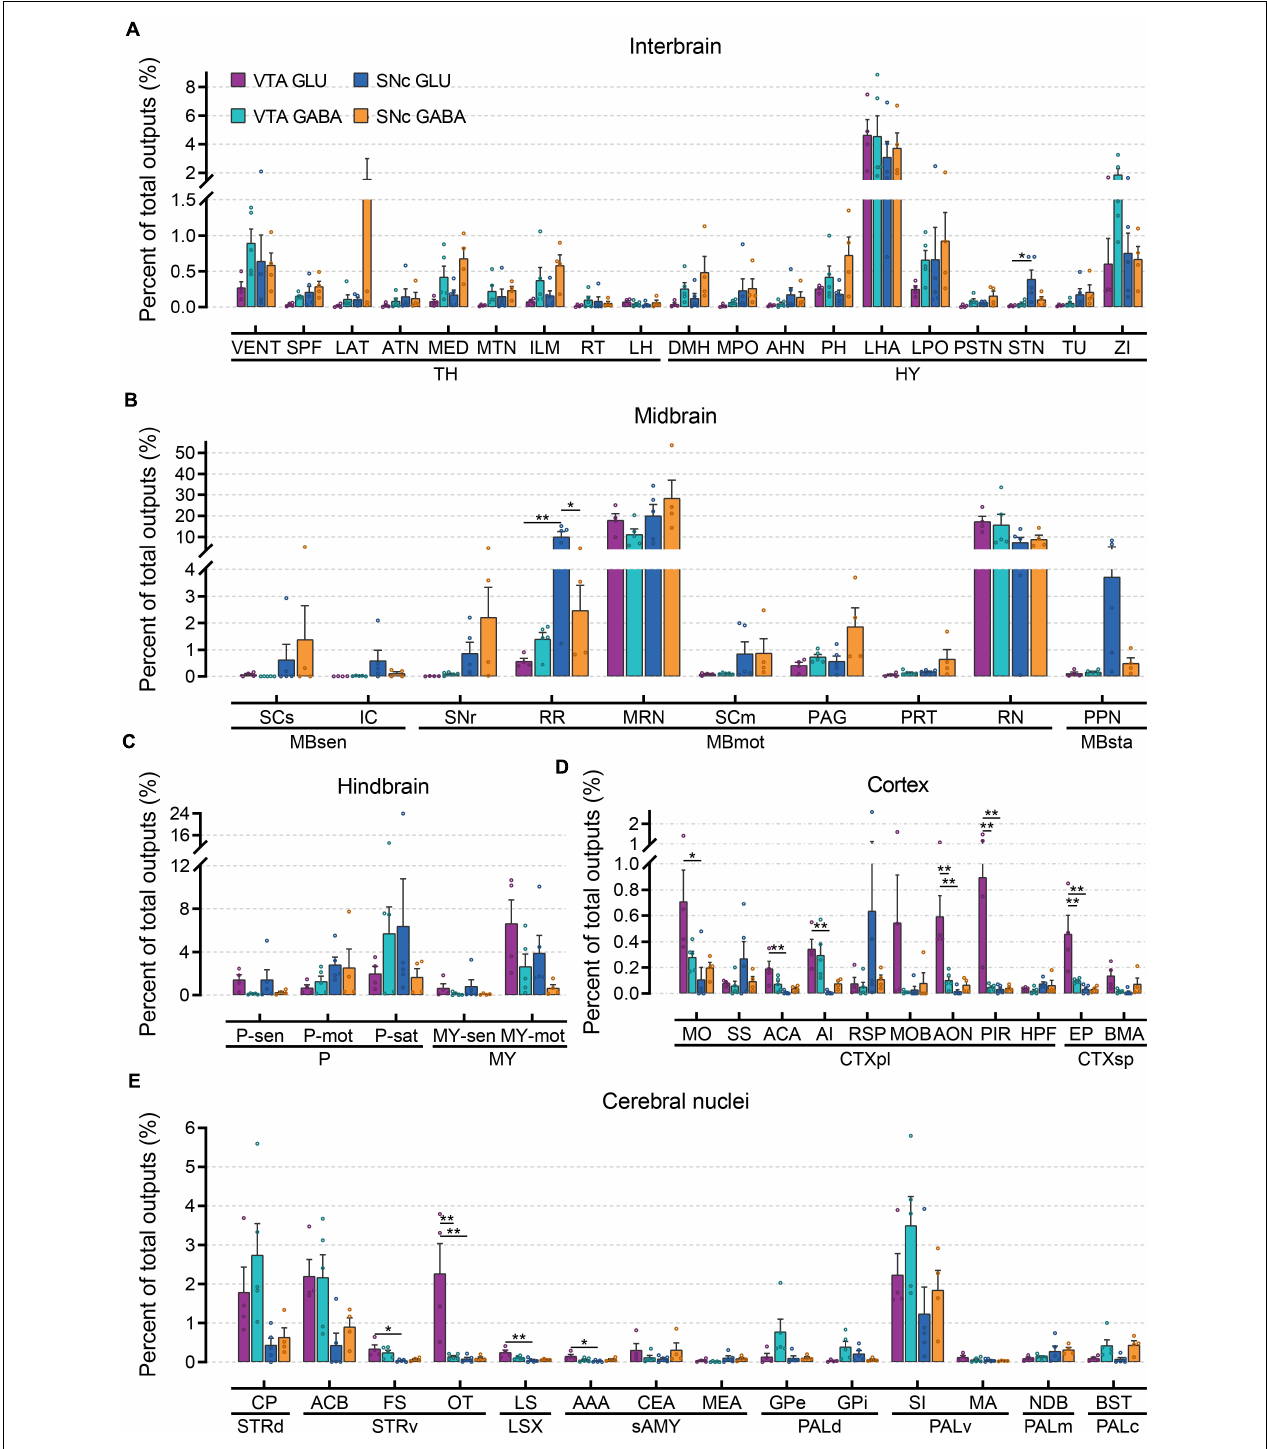
FIGURE 6 | Quantitative analysis of whole-brain output projections to glutamatergic and GABAergic neurons in VTA and SNc. (A) Proportions of total outputs in interbrain region. (B) Proportions of total outputs in midbrain region. (C) Proportions of total outputs in hindbrain region. (D) Proportions of total outputs in cortex region. (E) Proportions of total outputs in cerebral nuclei region. Mean ± SEM ( n = 5 mice each for the VTA GABA and SNc GLU groups, n = 4 mice each for the VTA GLU and SNc GABA groups). ** p < 0.01 and * p < 0.05. Only significant differences between the same cell type in different brain regions or between cell types in the same brain regions are marked; one-way ANOVA with Bonferroni correction. Abbreviations of the 61 brain regions and their percentages of outputs are listed in Supplementary Table 1 and Data 2 .